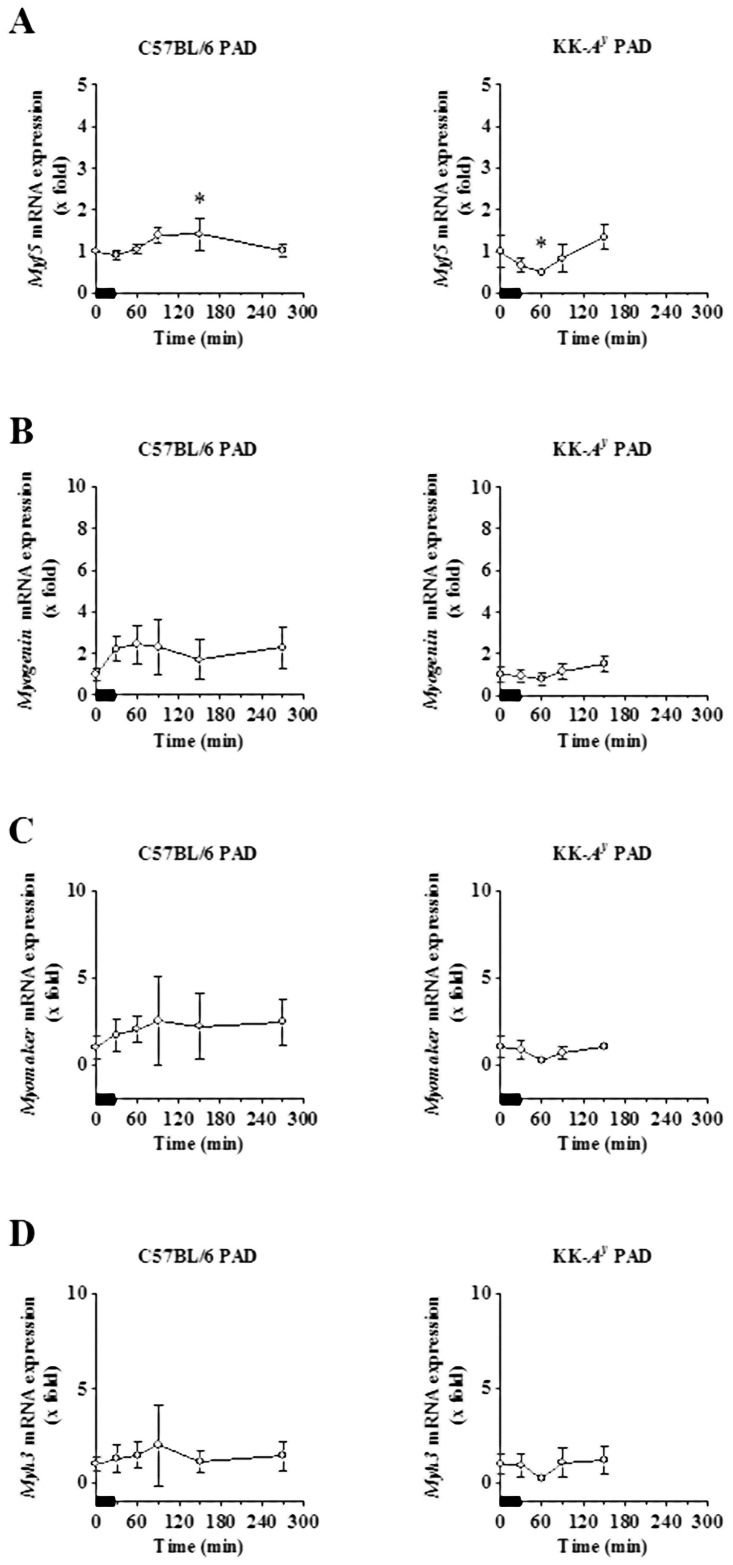
Acute effects of treadmill exercise on the mRNA expression of myogenic and muscle regeneration-related genes.The soleus muscles of exercised C57BL/6 PAD mice (left) and KK-Ay PAD mice (right) were obtained and the mRNA expression levels of Myf5 (A), Myogenin (B), Myomaker (C), and Myh3 (D) in the soleus muscles were determined, normalized, and calculated as described in the legend of Fig 2. The results are expressed as the mean ± SD. Bold bars represent the timing of the fifth treadmill exercise.